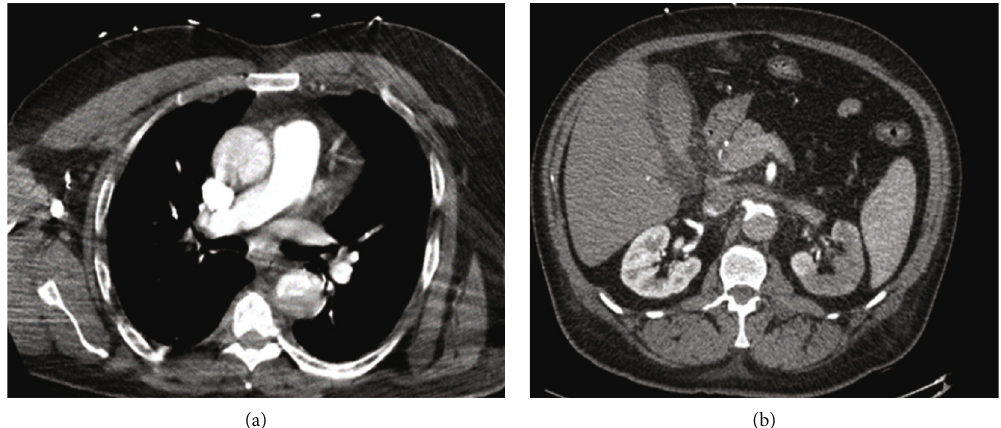
Figure 2: (a) Ascending aortic, descending aortic, and aortic arch aneurysm. (b) L renal infarct and descending aortic aneurysm.